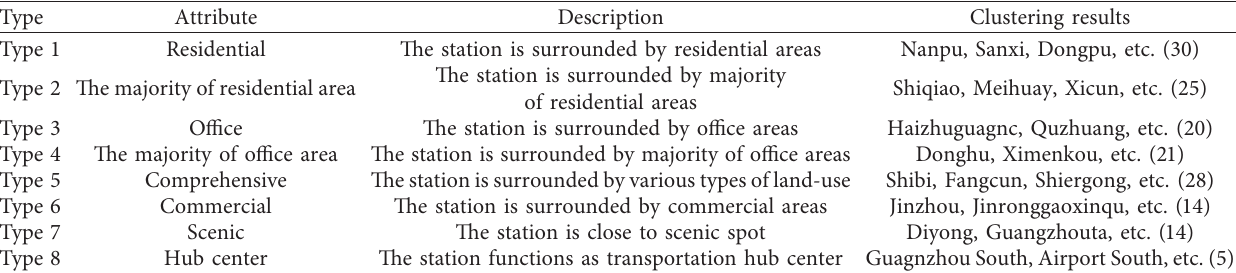
Table 3: Station types’ clustering results based on the surrounding area’s land-use.